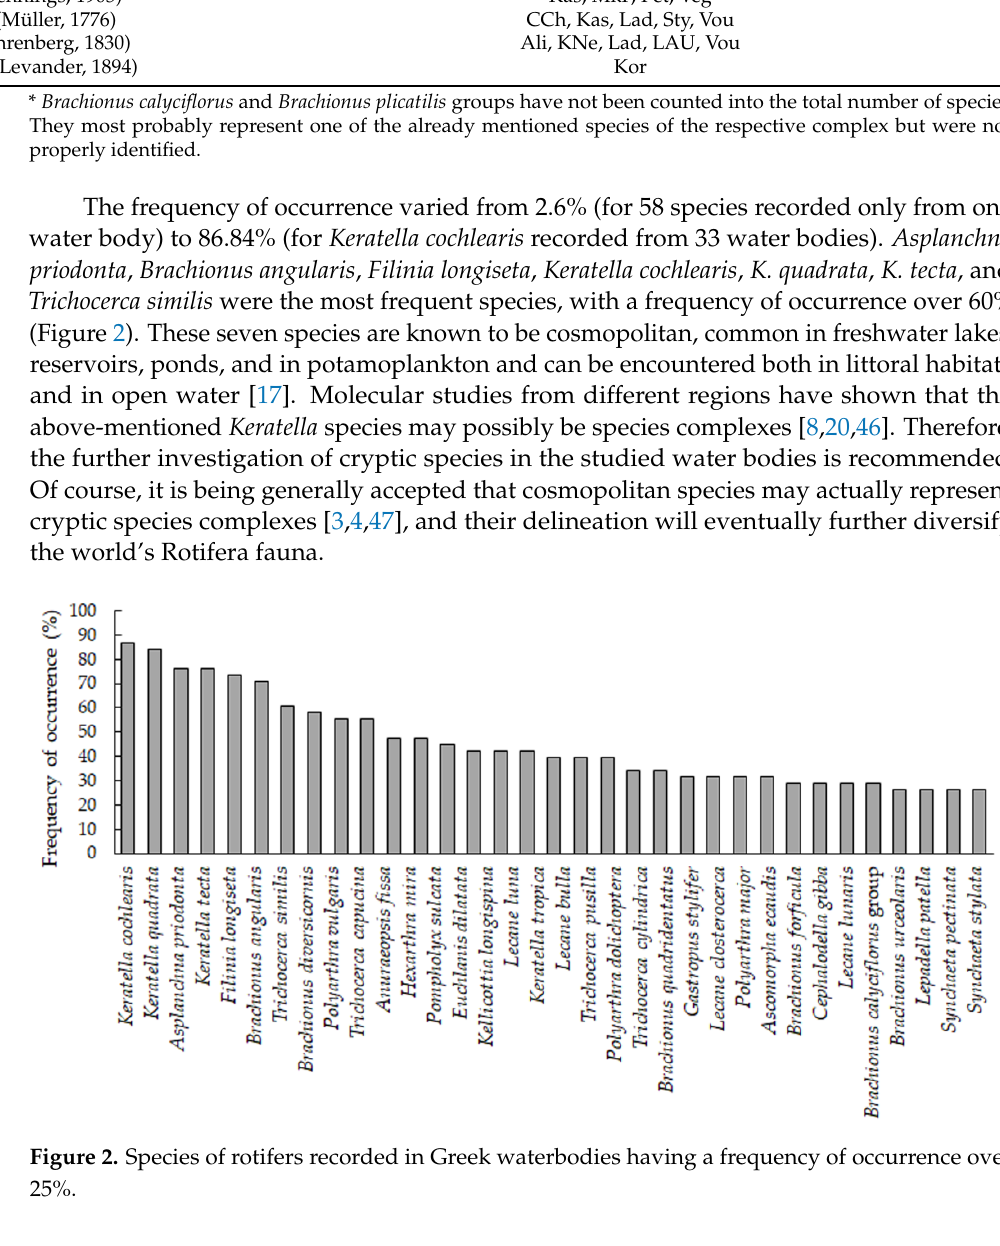
Figure 3. Estimation of diversity of rotifers in Greek waterbodies using the estimators Chao2 and Jackknife2.